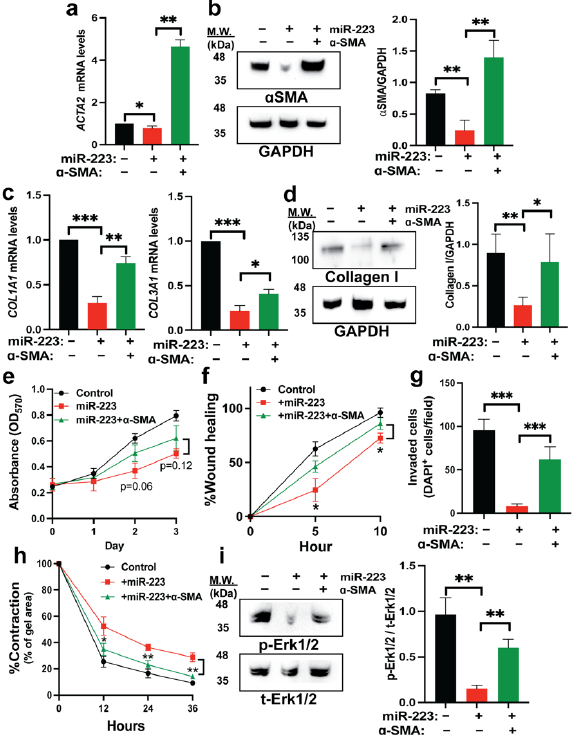
Figure 5. Reconstitution of α -SMA partially restores activation phenotypes of miR-223-overexpressing HSCs. ( a , b ) Expression of alpha-smooth muscle actin ( α -SMA) in control, miR-223, miR-223 with α -SMA overexpression HSCs by immunofluorescence and Western blot. ( c ) Expression levels of COL1A1 and COL3A1 mRNAs upon α -SMA reconstitution by qRT-PCR. ( d ) Protein expression of type I collagen upon α -SMA reconstitution by Western blot. ( e ) Rate of HSC proliferation as determined by the MTT assay. ( f ) Scratch assay to determine ability of cell migration. ( g ) Quantification of invaded cell number after seeding in a Matrigel-coated Transwell for 24 h with chemoattractant (2% FBS). Invaded cells were counted from 10 random microscope fields for each group. ( h ) Gel contraction assay measured at 12 h intervals after the lattices were dislodged. ( i ) Levels of phosphorylated ERK1/2 upon α -SMA reconstitution determined by Western blot in basal medium conditions. Data presented as the mean ± SD and expressed relative to those of control HSCs (set as 1.0) for qRT- PCR experiments. N = 3–4 replicates from at least two independent experiments. Student’s t -test; * = p < 0.05, ** = p < 0.01 and *** = p <